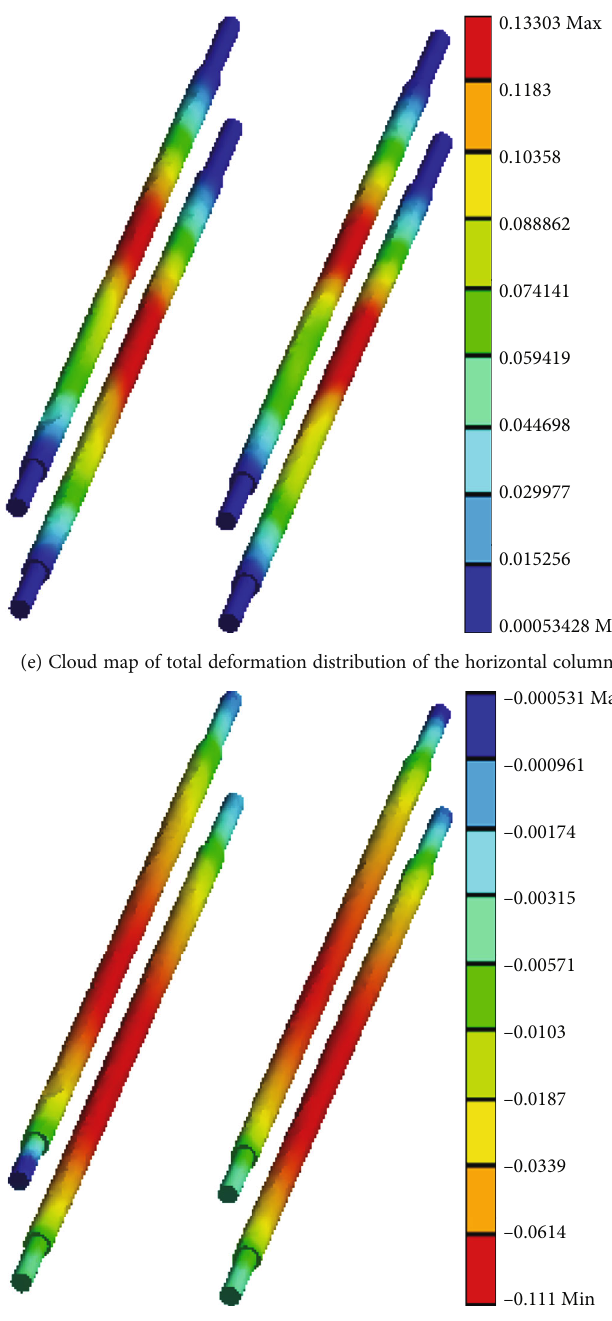
Figure 10: Numerical simulation results of the horizontal tensile